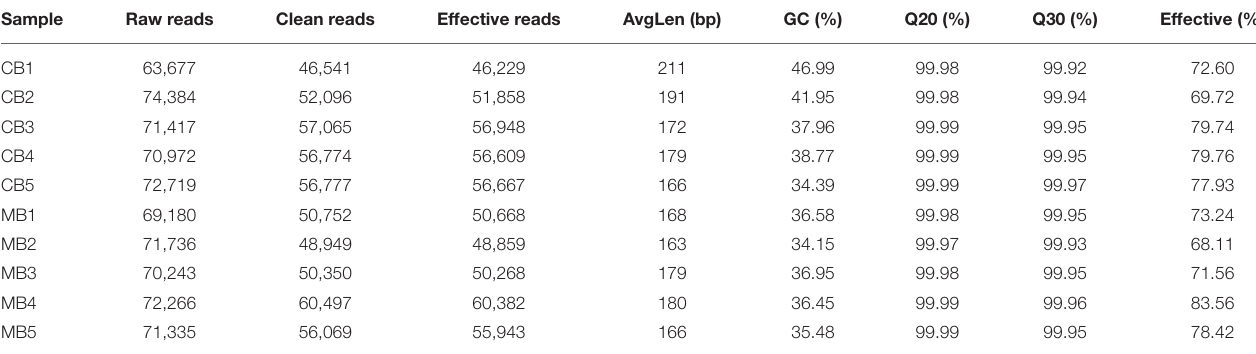
TABLE 2 | Fungal sequence information from amplicon sequencing.